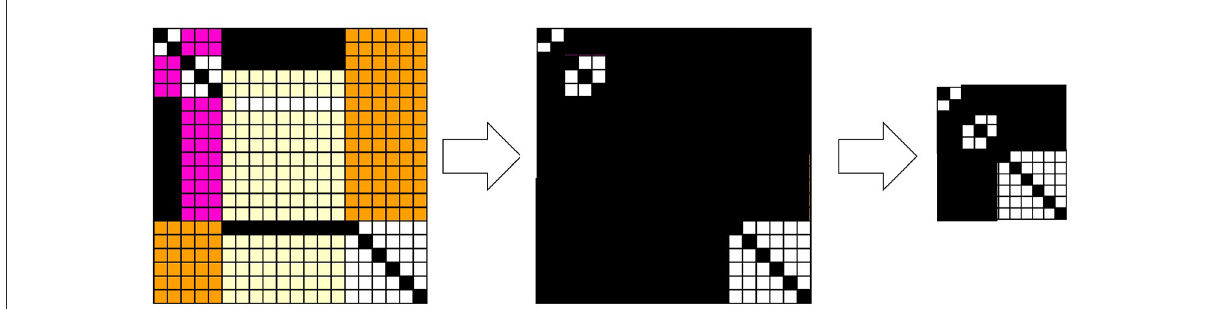
FIGURE4 Snapshots of the joint probabilities of data and hypotheses and their corresponding relation R . The articulation of the data and hypotheses with respect to the diagonal elements is determined by Equation 23. The joint probabilities are colored from low to high in the order of white, pale yellow, orange, pink, and black (left). A black cell at ( h , d ) represents ( h , d ) ∈ R , and a white cell represents ( h , d ) / ∈ R (center